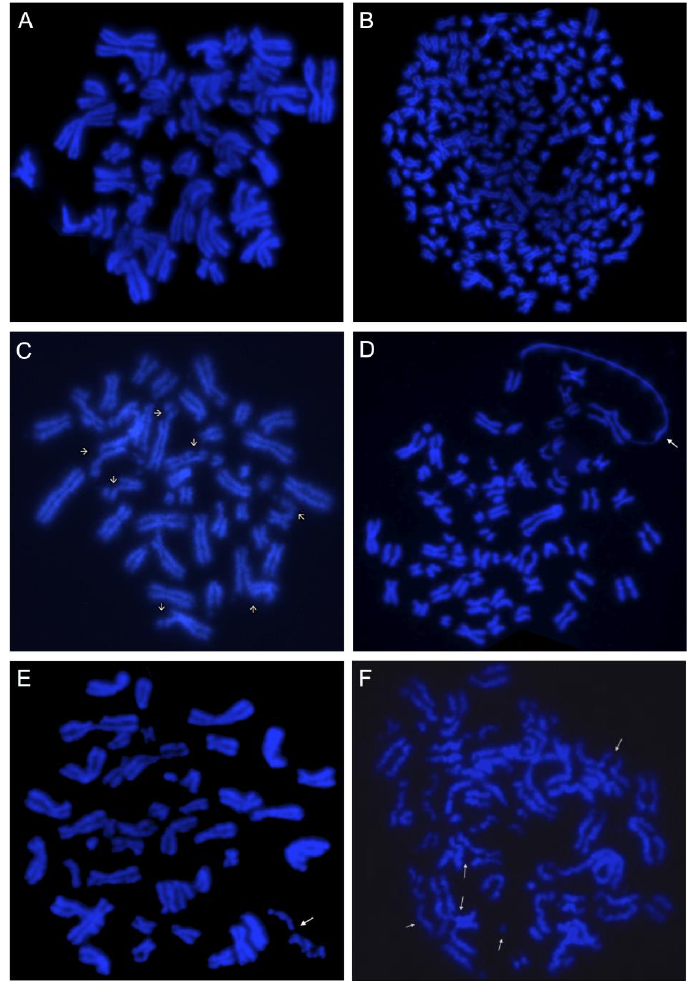
Figure 1. Examples of chromosomal chaos observed in cancer. ( A ) DAPI image of a metaphase with numerical alterations. In these cells, the absence of cell division leads to endoreduplication, a form of nuclear polyploidization that results in multiple uniform changes connected at the centromere. ( B ) DAPI image of a metaphase with polyploidy. In these cells, the chromosome number is greater than 46. ( C ) DAPI image of a metaphase with structural chaos, where chromatid breakage and single sister chromatids are visible (indicated by arrows). ( D ) DAPI image of a metaphase showing a defective mitotic figure. In this metaphase it is possible to observe the co-existence of condensed chromosomes and undercondensed chromatin fibers (indicated by the arrow) within one mitotic figure. ( E ) DAPI image of a metaphase showing early stage C-Frag where most chromosomes are intact. The chromosome being degraded is denoted by the arrow. ( F ) DAPI image of a metaphase with chromosome breakage and several large-scale chromosome fusions. Broken and fused chromosomes can be clearly seen (indicated by